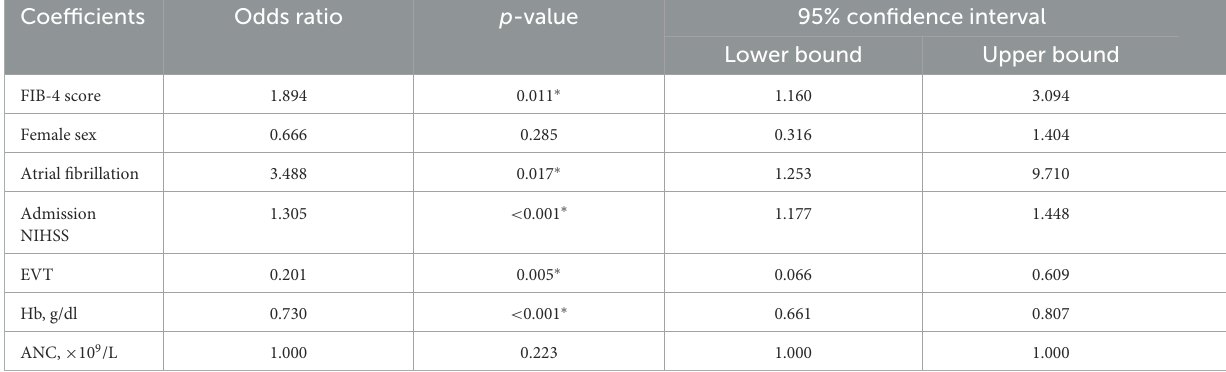
TABLE 3 Logistic regression: FIB-4 score influence on 3-month mRS (primary outcome).